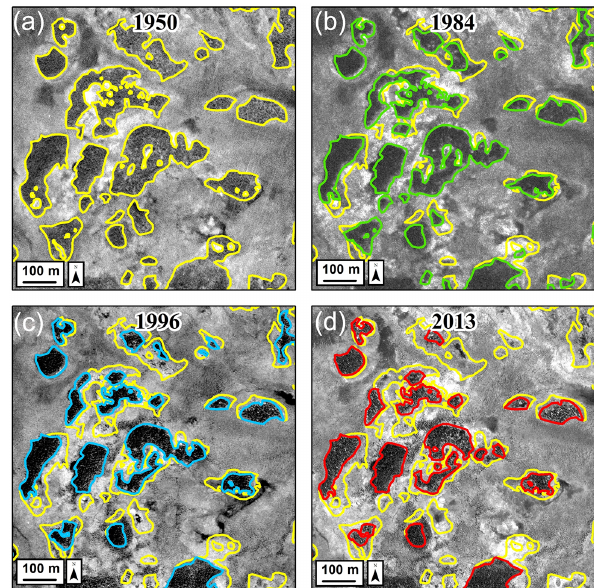
Figure 4. Time series documenting the extent of a subset of per- mafrost features in the Browns Lake wetland complex in (a) 1950, (b) 1984, (c) 1996, and (d) 2013. Permafrost plateau extent in 1950 is shown as a yellow polygon in each frame and other time slices outlined as green (1984), blue (1996), and red